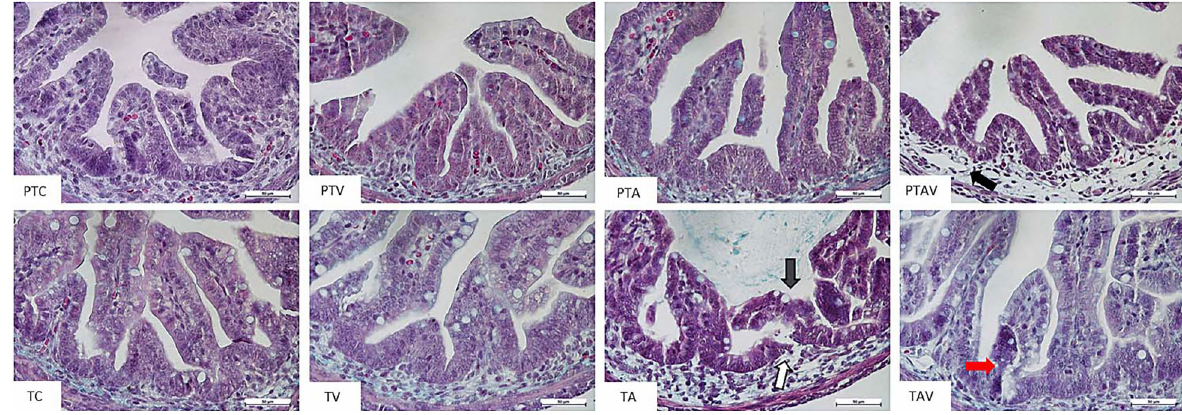
Figure 3 . Photomicrograph of newborn rat brain immunostained for caspase-3. Cerebral cortex: A : preterm asphyxiated and ventilated (PTAV); B : preterm control (PTC); C : term asphyxiated (TA); D : term control (TC). Hippocampus: E : TA; F : TC. In the preterm group, caspase-3 expression was signi fi cantly higher in the cortex area of the PTAV compared with the PTC subgroup (P o 0.05). In the term group, the caspase-3 expression was higher in the cortex and hippocampus areas of the TA compared with the TC subgroup. Note intensely marked astrocytes with hypertrophic processes (arrows). Magni fi cation: 100 (cid:1) (oil immersion); scale bar: 10 m